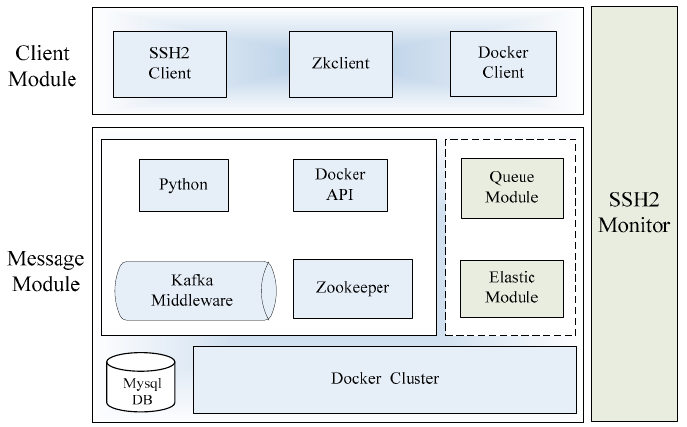
Figure 5. Prototype design of Elastic-Docker. SSH2: Secure Shell; API: Application Program Interface; DB: DataBase.